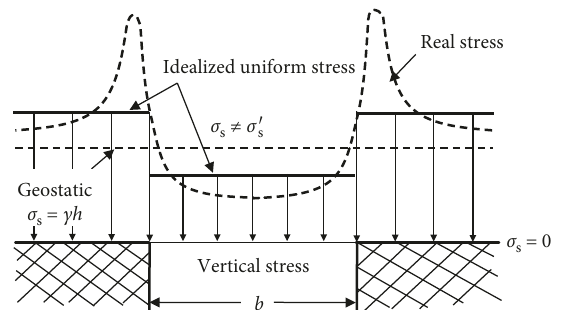
Figure 5: Distribution of overlying vertical stress at the bottom of